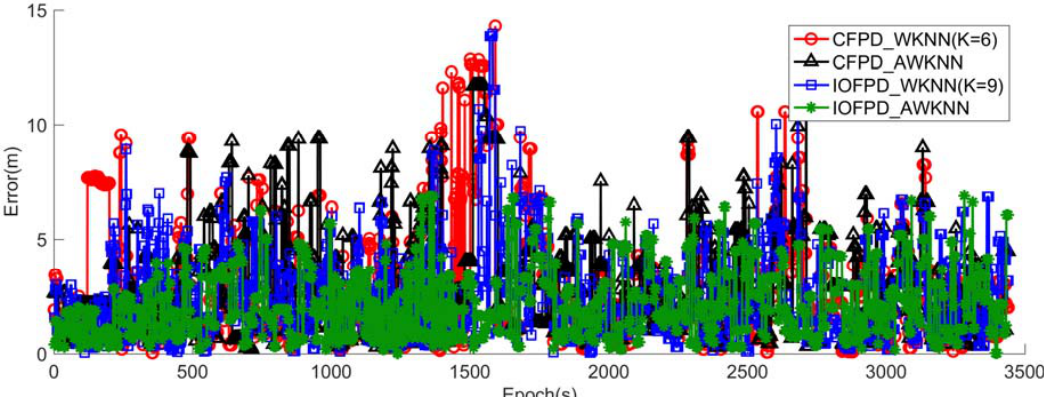
Figure 6. The positioning errors of the CFPD_WKNN method, the CFPD_AWKNN method, the IOFPD_WKNN method and the IOFPD_AWKNN method, where the CFPD_WKNN and IOFPD_WKNN method get the best positioning performance when K are 6 and 9, respectively.